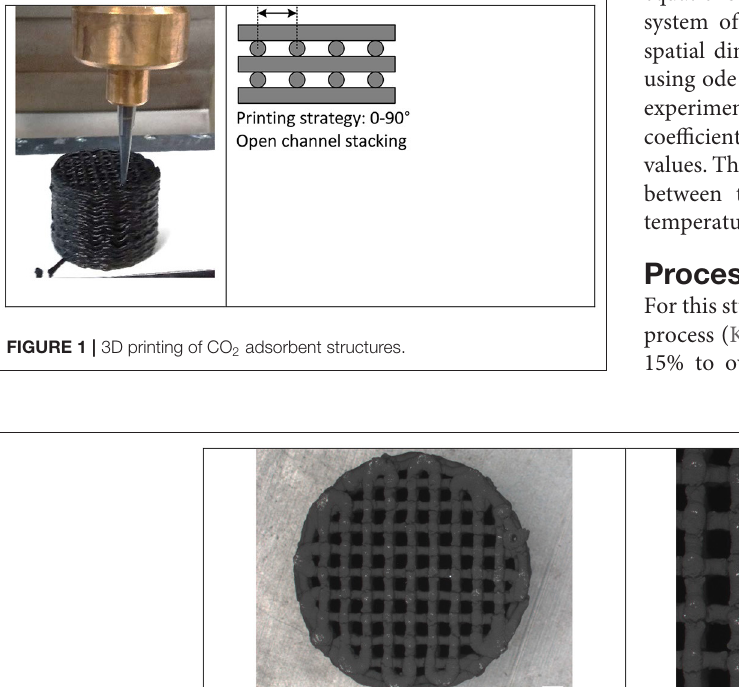
Frontiers in Climate |